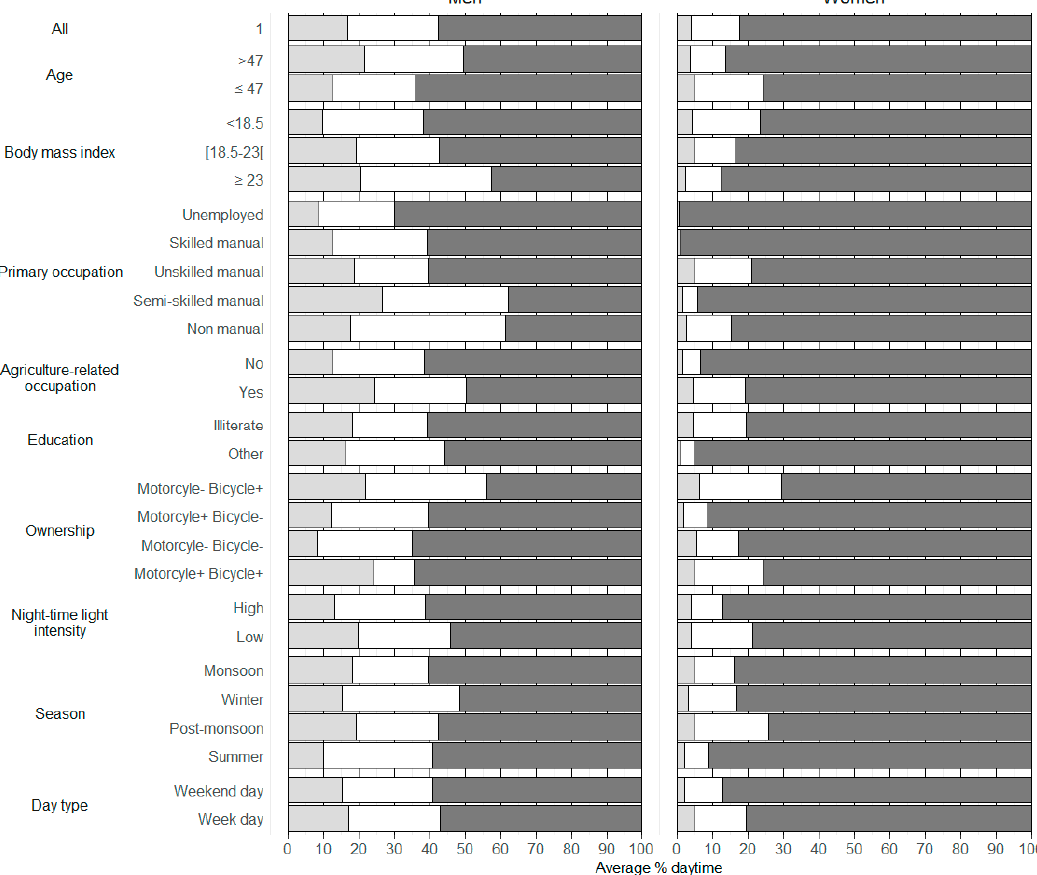
Figure 1. Percent of daytime spent at home (dark grey), in activity locations (white) and trips (light grey) according to selected characteristics. Home, activity locations, and trips identified by an automated algorithm within GPS tracks. Body mass index is expressed in kg/m 2 . Night-time light intensity was used as marker of village urbanicity. Low and high categories for night-time light intensity were derived from population median value. All tests comparing men and women values were significant at the 5%